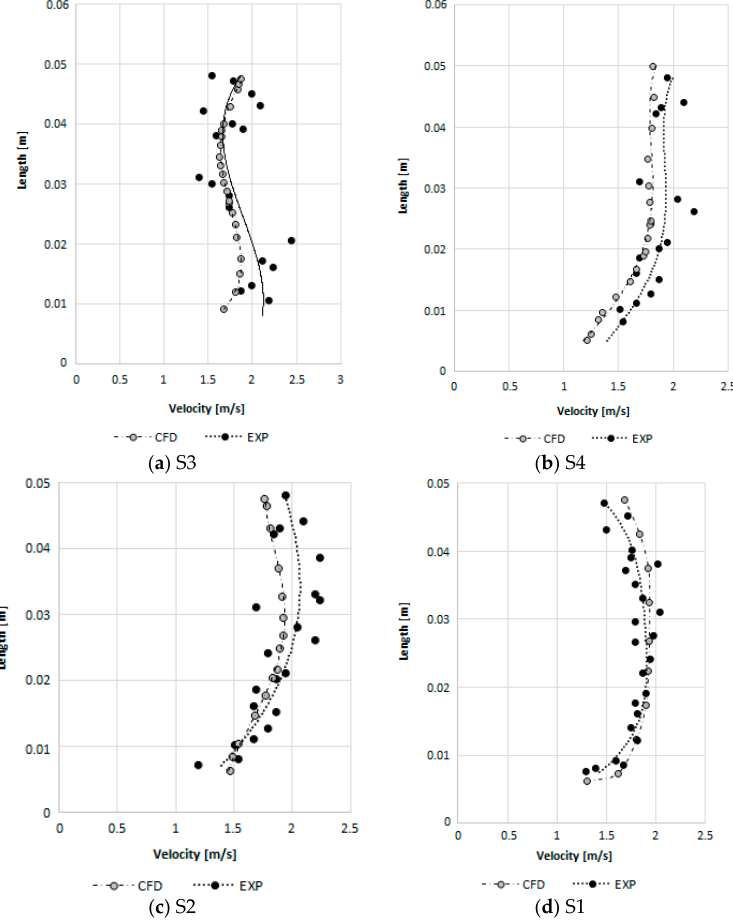
Figure 7. Velocity profiles (m/s) obtained through experimental tests and CFD simulations: ( a ) N = 850 rpm; ( b ) N = 880 rpm; ( c ) N = 880 rpm; ( d ) N = 1140 rpm. Table 5. Results obtained in experimental tests and CFD model for different rotational speeds.